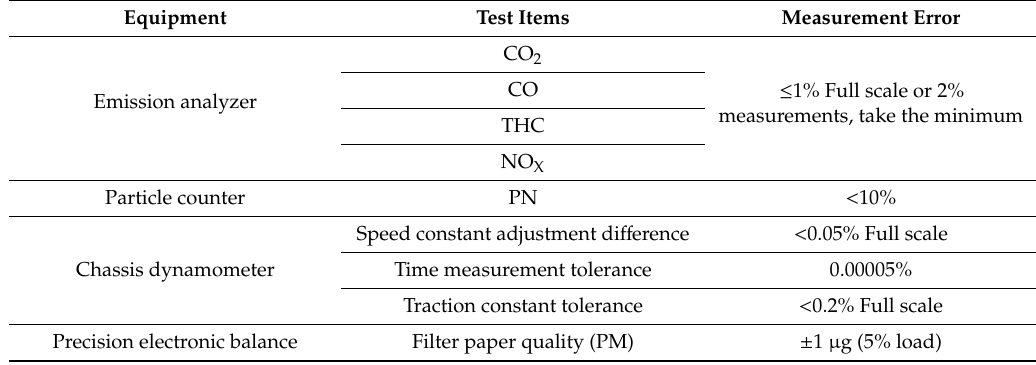
Table 3. Measurement errors of major instruments and equipment. PN: particle number, PM: particulate matter. 193